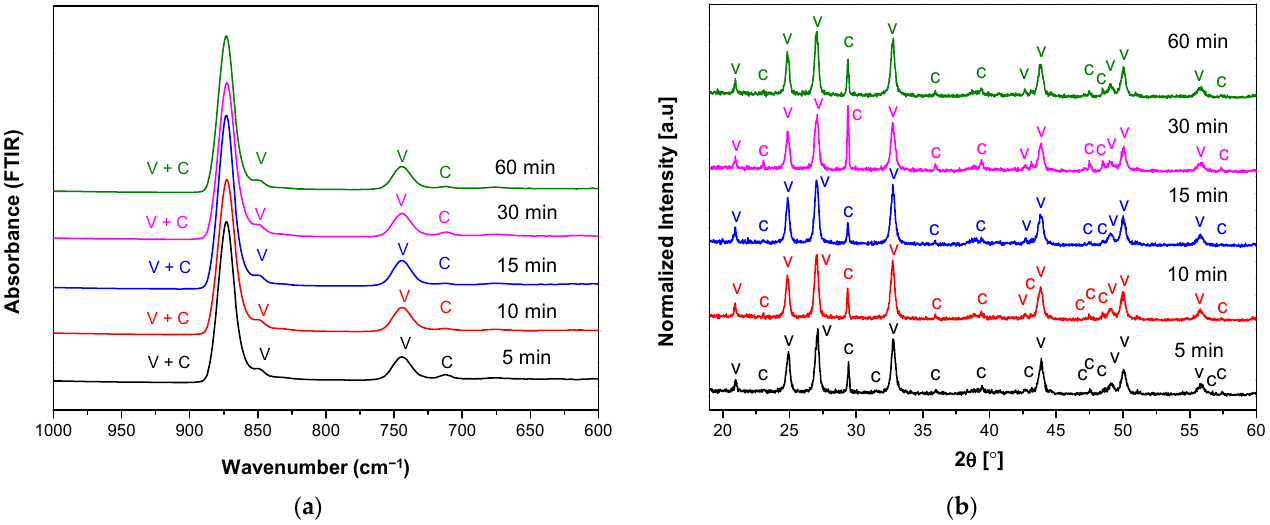
Figure 6. ( a ) FTIR and ( b ) XRD spectra of vaterite synthesized at 27 °C for different reaction times (5–60 min) at stirring speed 1000 rpm. Polymorphs main peak is indicated (V = vaterite, C = calcite). Table 4. Effect of reaction time on the as-prepared CaCO 3 polymorph ratio and size of crystallite (at a temperature of 27 ◦ C and stirring speed of 800